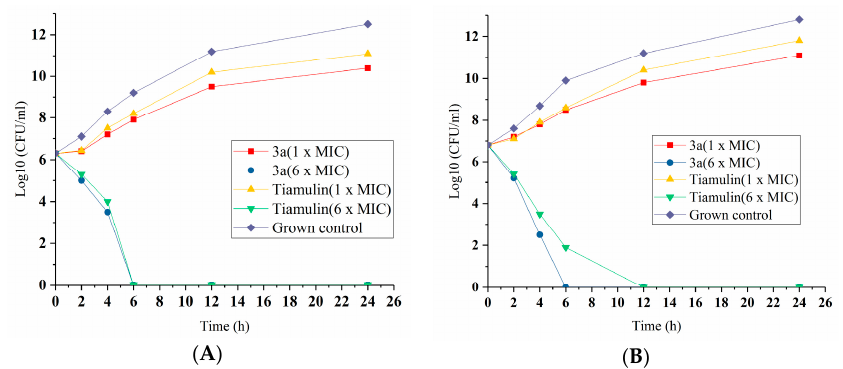
Figure 3. Time-kill kinetics of compound 3a against S. aureus (ATCC 25923) ( A ) and MRSA (ATCC 43300) ( B ). Mean values of the CFU/mL (colony forming units per milliliter) were obtained from measurements taken in triplicate. Table 1. Antibacterial activity (Minimum Inhibitory Concentration) of the synthesized pleuromutilin derivatives. Compound